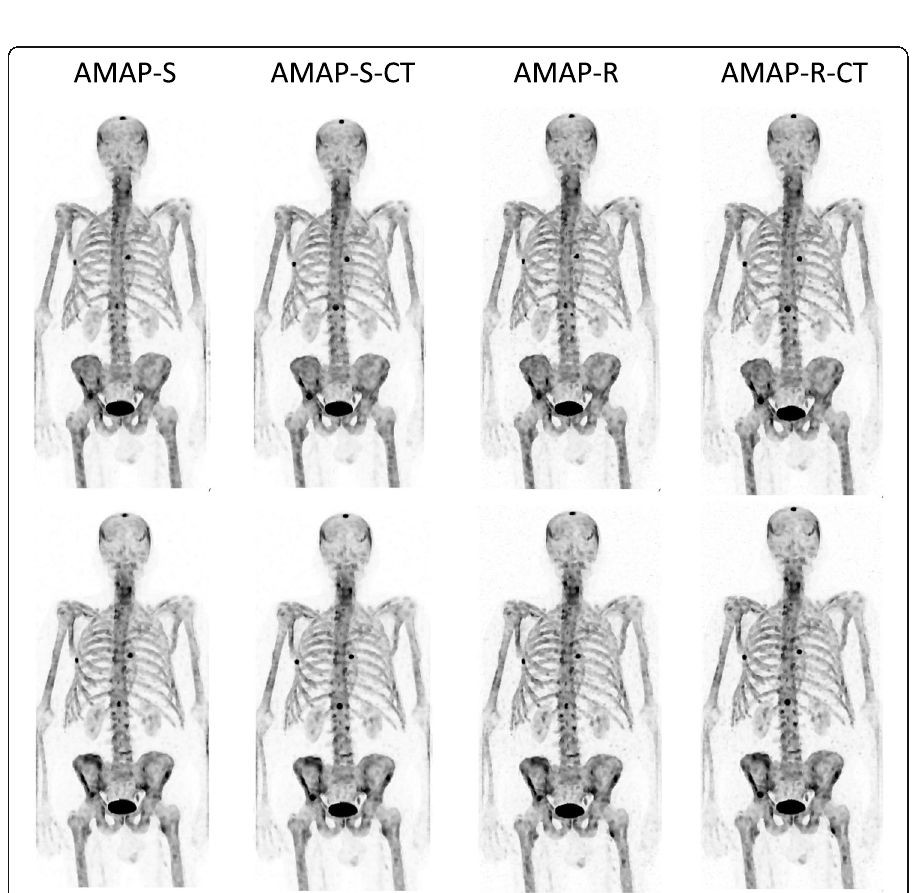
Fig. 5 Anterior maximum intensity projections of the male patient study with artificial lesions with SPECT/ CT mismatch. AMAP-S and AMAP-R refer to reconstructions where lesion is absent in the CT and AMAP-S CT and AMAP-R CT to lesion-present cases. Top row shows perfectly aligned cases and bottom row reconstructions with the 5-mm SPECT/CT mismatch. The color scale is set to SUV 15 for all images